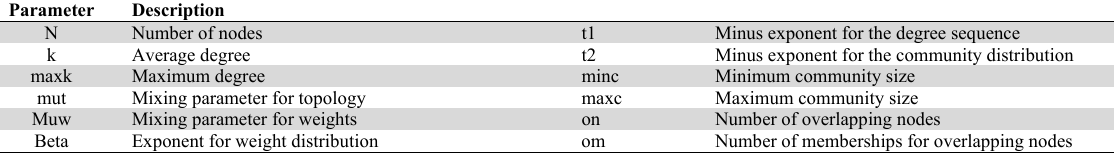
Benchmark generator algorithm parameters